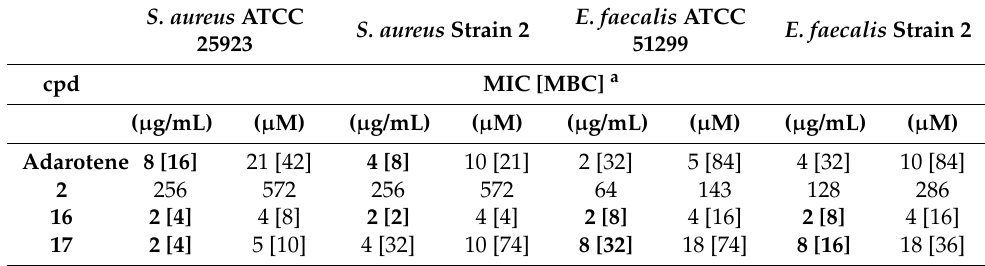
Table 2. Antimicrobial activity of selected compounds against strains of S. aureus and E. faecalis